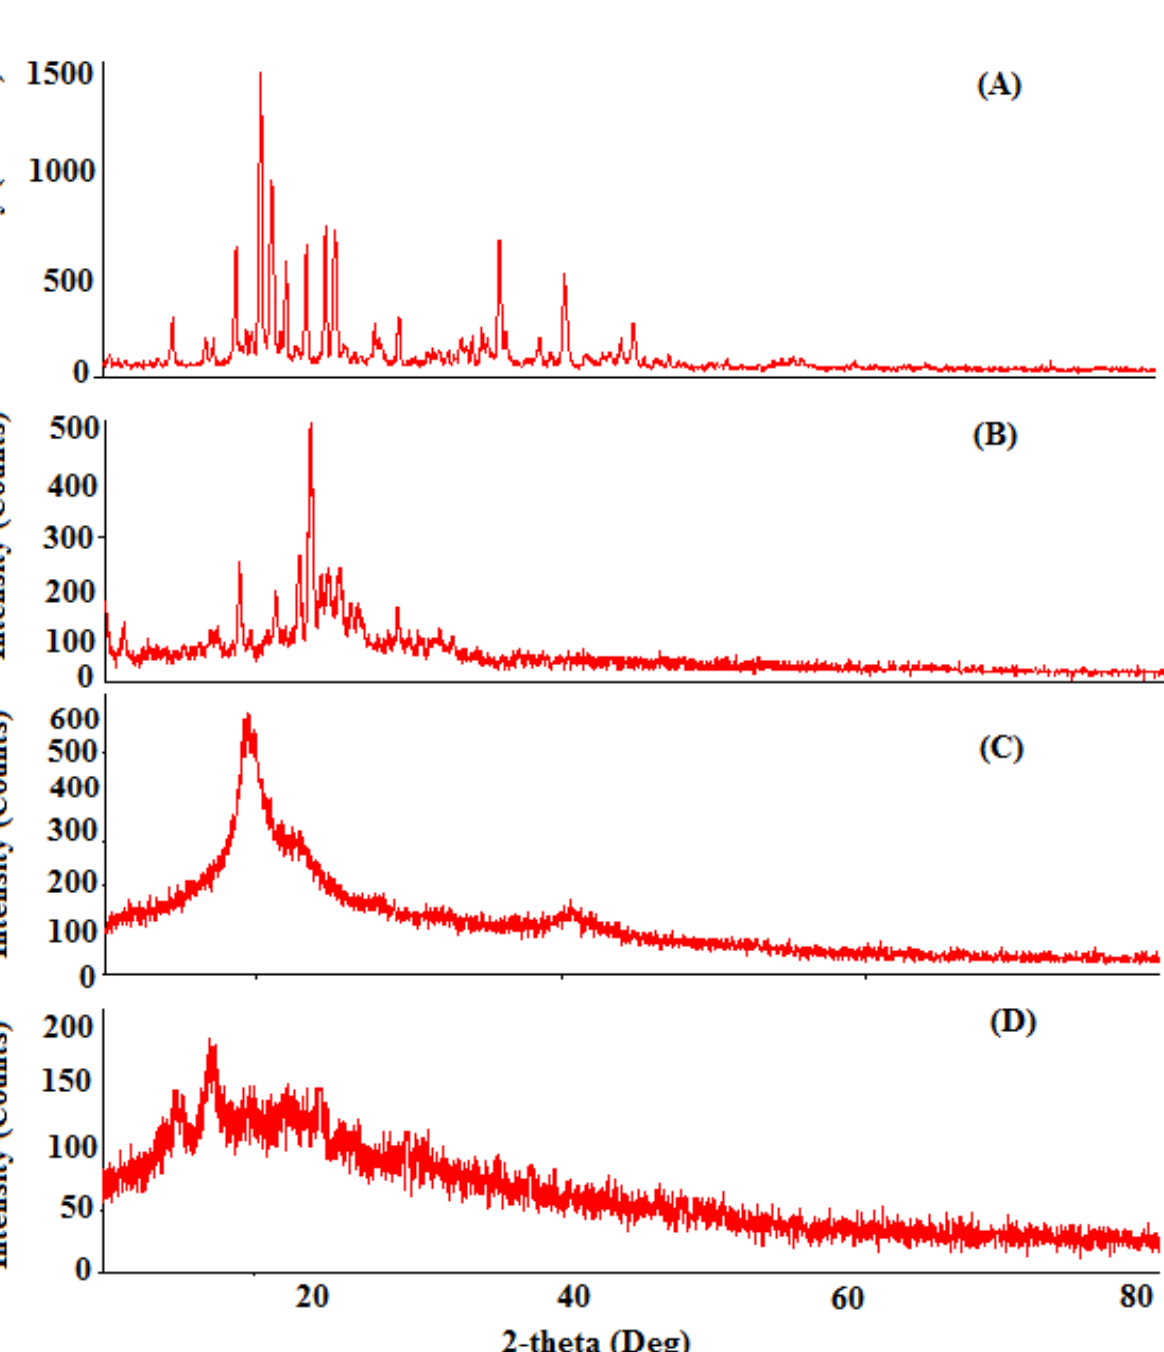
Figure 8. The XRD diffraction analyses of Erlo ( A ), cinnamon biopolymer ( B ), Dox–Erlo NPs ( C ), and Dox–Erlo-NP conjugates ( D ).